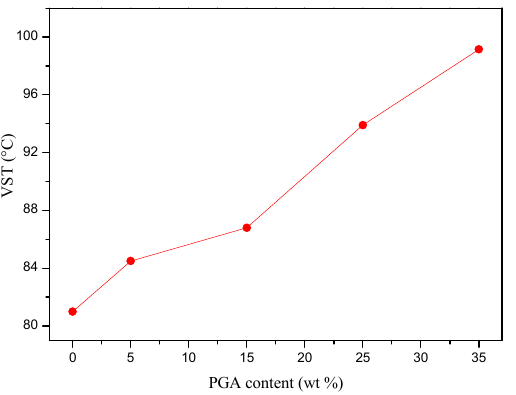
Figure 6. Influence of PGA content on Vicat softening temperature (VST) of PETG/PGA samples.